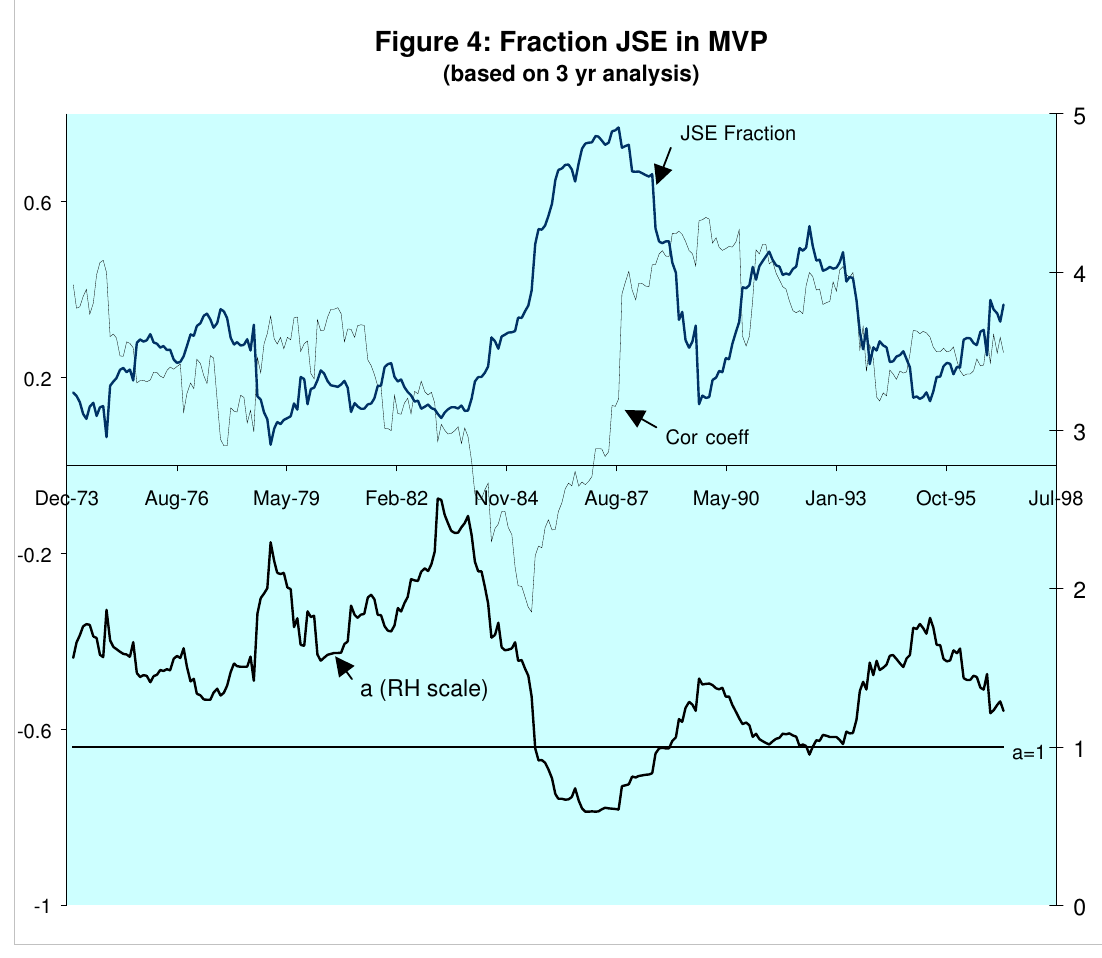
Figure 4: Fraction JSE in MVP (based on 3 yr